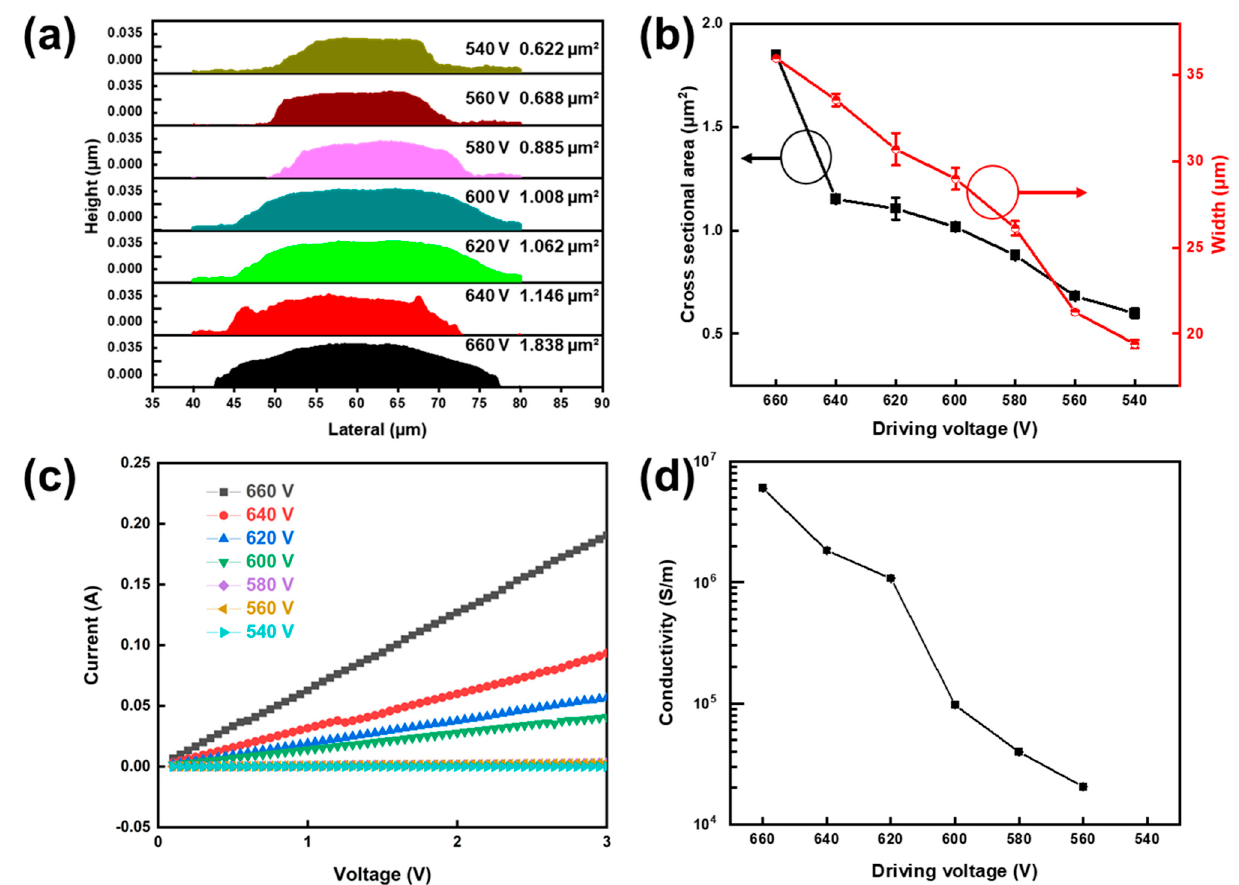
Figure 6. Profile morphology and electrical conductivity of EHD − printed silver electrodes: ( a ) Topography of cross − sectional area; ( b ) cross − sectional area and line width under different driving voltages; ( c ) volt–ampere curves under different driving voltages; ( d ) electrical conductivity under different driving voltages.